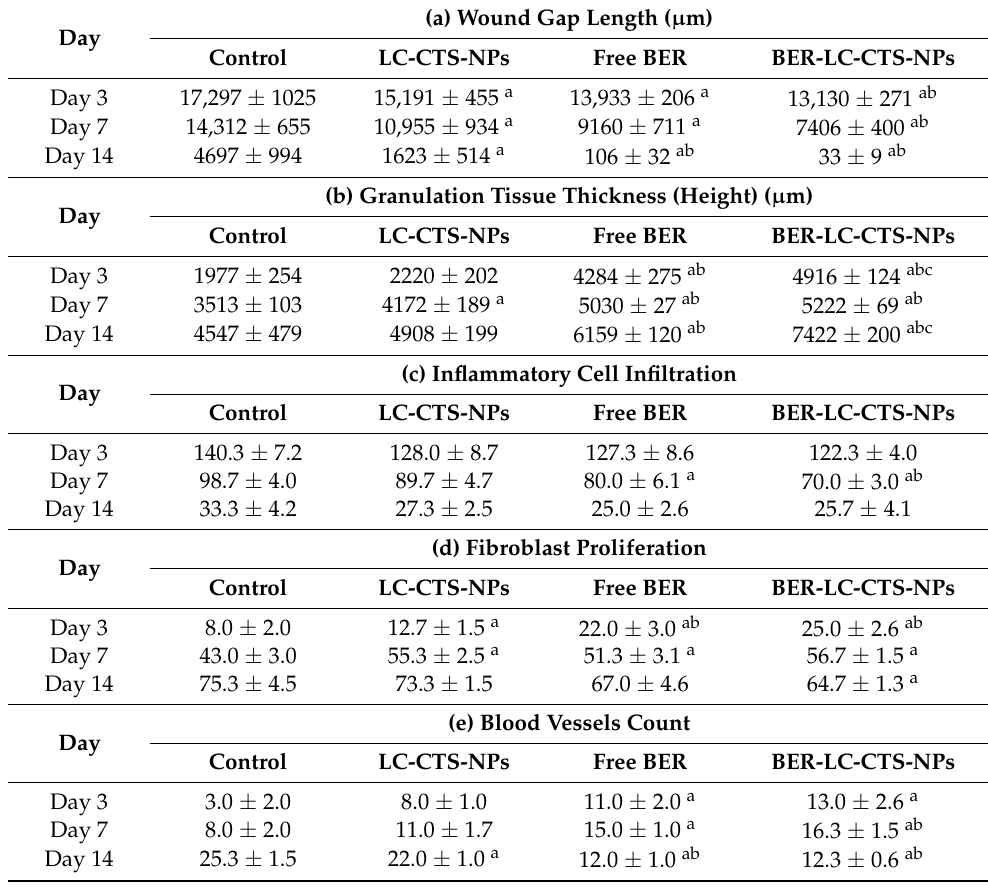
Table 4. Microscopic evaluation of wound healing of the skin in the diabetic rats of the Control, LC-CTS-NPs, Free BER, and BER-LC-CTS-NPs treated groups using sections stained with H&E × 40 ( a , b ) and sections stained with H&E × 400 ( c – e ). Data were expressed as mean ± SD ( n =